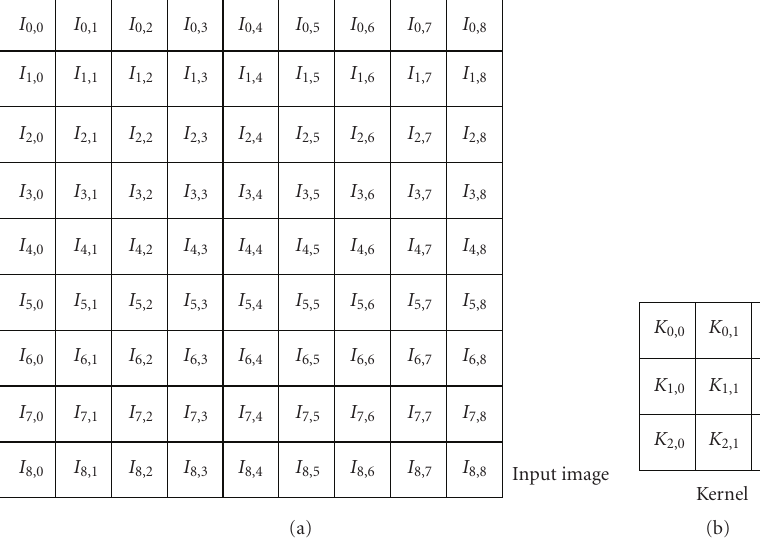
Figure 9: An example small image (a) and kernel (b) to illustrate convolution.